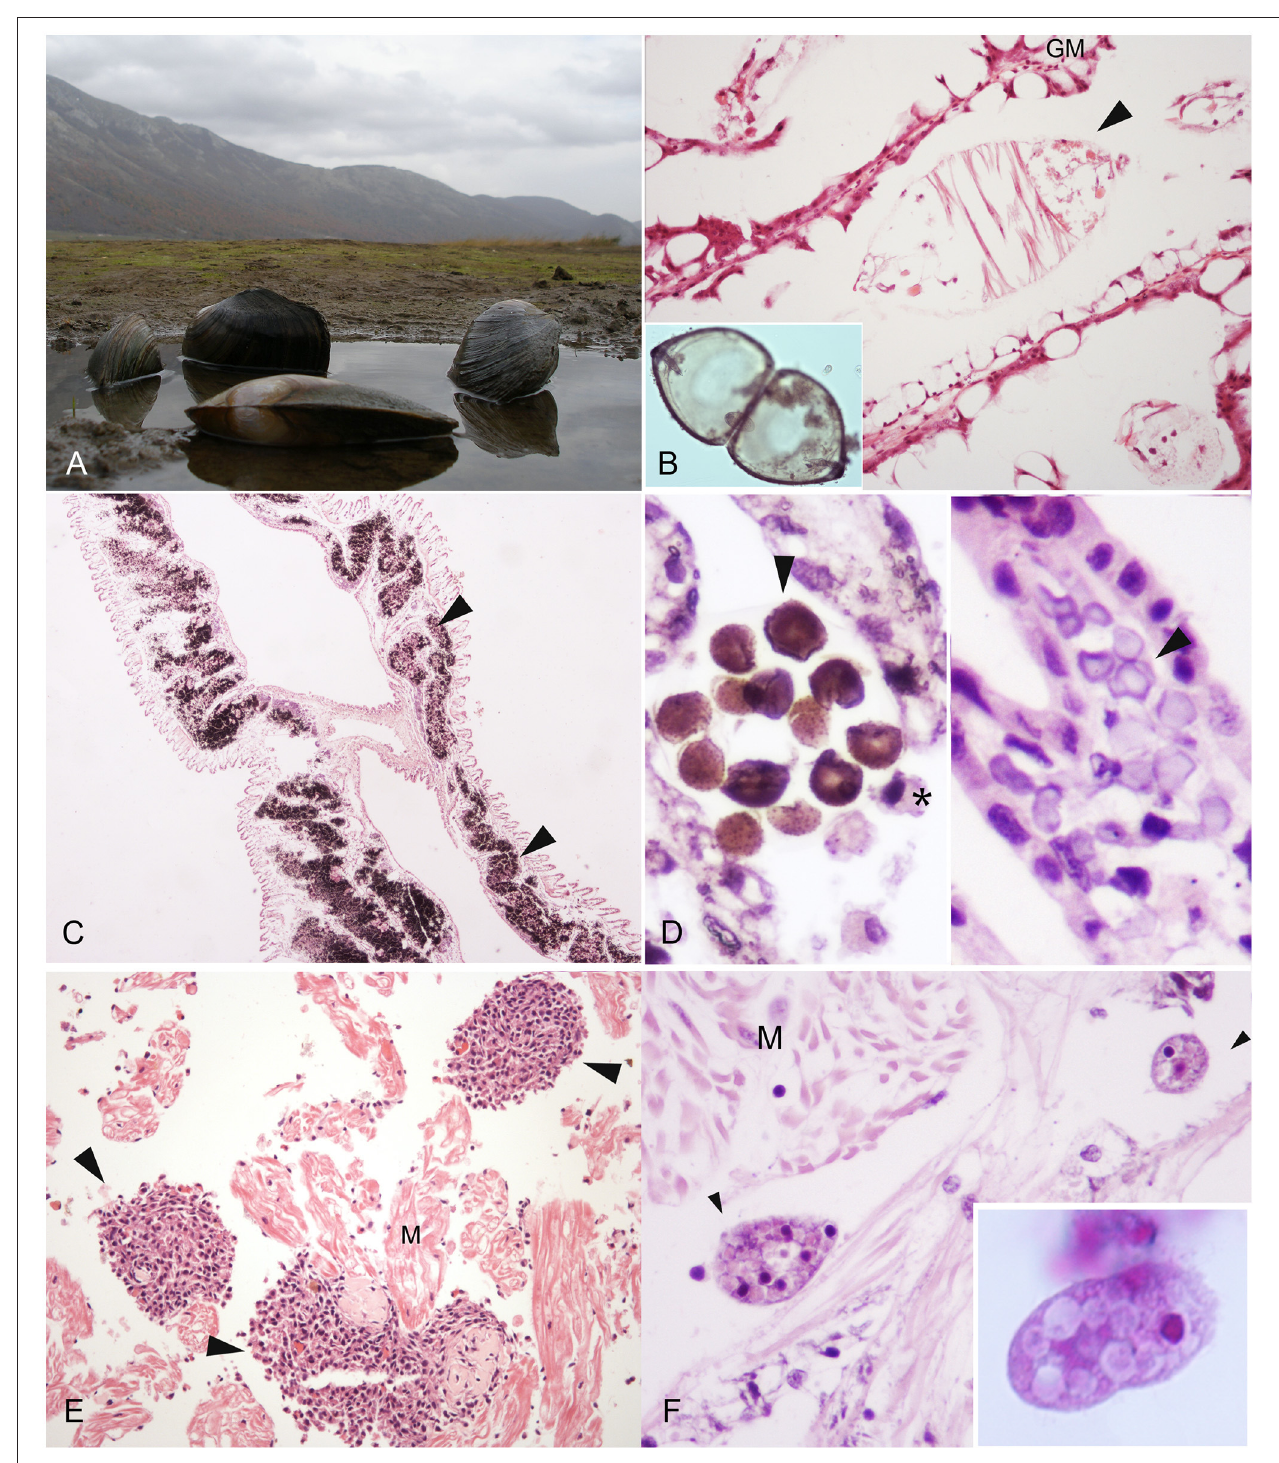
FIGURE 1 | Macro-microscopical observation of pathogen and disease in freshwater mussel species. (A) Anodonta cygnea from Matese Lake (Caserta, Campania region) H&E; (B) Glochidium of Anodonta woodiana in the gill marsupium (GM), H&E, 40X; (C) Calcium Concretions (arrowheads) in the gills of Unio pictorum visible in black, Von Kossa Stain, 20X; (D) Calcium concretions in gills: Stain for Copper (Left), H&E (right) 40X; (E) Inflammatory nodulation (arrowheads) in heart muscle fibers (M) in A. anatina E&E, 40X. (F) Conchophthirus spp. (arrowheads) in the mantle of Unio pictorum , E&E, 100X. *Haemocyte (M): muscle.